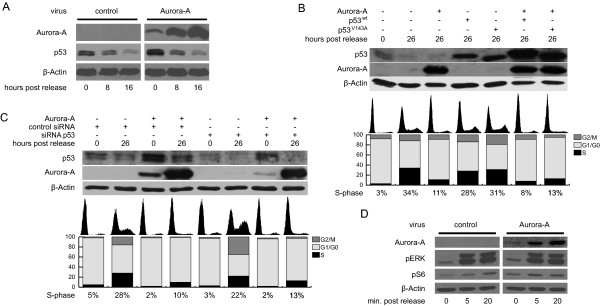
Importance of known Aurora-A interactions for cell cycle inhibition. (A) Wi-38 cells were arrested in G0 by serum deprivation and infected with adenoviruses expressing Aurora-A or control virus expressing lacZ and analyzed by immunoblotting with the antibodies indicated. (B) Quiescent cells were infected with adenoviruses expressing the indicated proteins and analyzed by immunoblotting and PI staining at time points 0 and 26 hours after serum addition. (C) Serum arrested cells expressing Aurora-A or lacZ were transfected with the indicated siRNA 24 hours prior to serum addition. At the indicated time points cells were harvested and analyzed as in (B). (D) Serum deprived cells infected with control or Aurora-A expressing viruses were harvested at the indicated times and analyzed by immunoblotting with antibodies recognizing phosphorylation of ERK1/2 and ribosomal protein S6, respectively. For all illustrations, representatives of at least two independent experiments are shown.